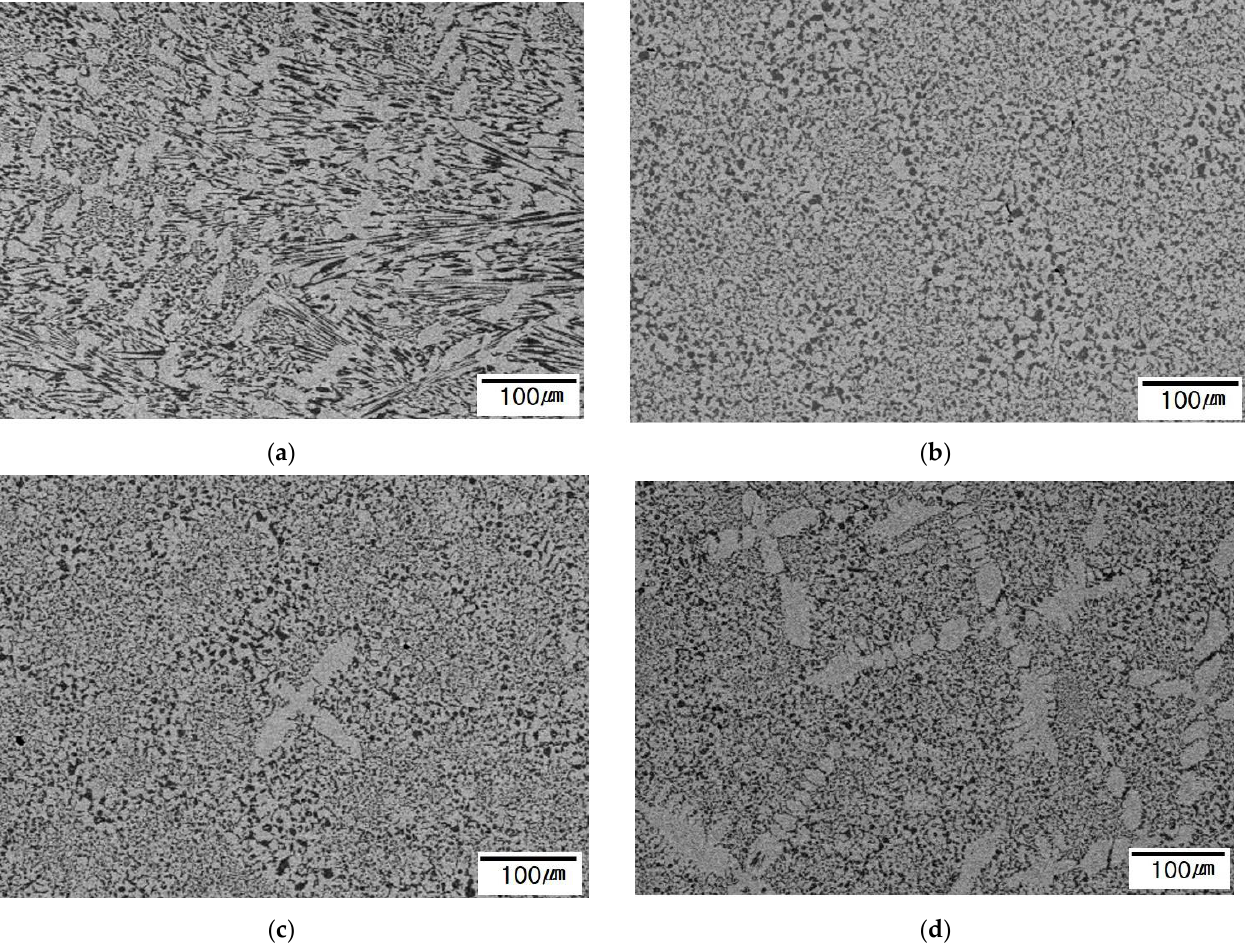
Figure 3. Micrographs normal to the solidified direction. ( a ) equiaxed mother alloy; ( b ) 10 µ m/s; ( c ) 25 m/s; ( d ) 50 m/s.